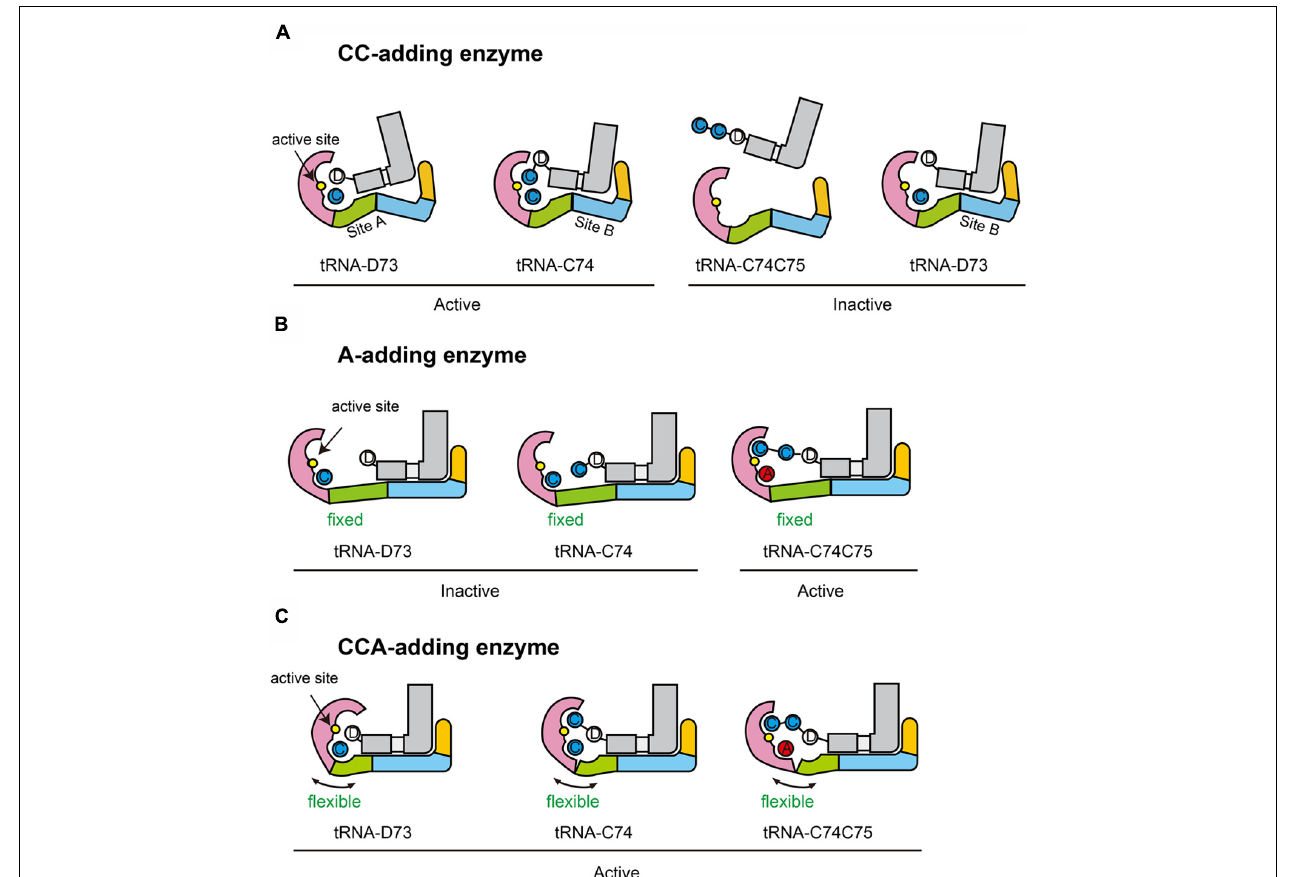
FIGURE 8 | Hypothetical mechanisms of nucleotide addition by class-II enzymes. (A) CC-addition by CC-adding enzyme possessing two tRNA binding sites (sites A and B). Sites A and B are used for C 74 - and C 75 -addition, respectively. When a tRNA ending with the discriminator nucleoside (D 73 ) is on site B, the 3 (cid:2) -terminal D 73 cannot reach the active site for catalysis (inactive state). A tRNA ending with C 74 C 75 cannot bind either site A or B. (B) A-addition by A-adding enzyme, possessing a single tRNA binding site. The neck domain is not flexible. The tRNA binds the enzyme, using the single site. On this site, the 3 (cid:2) -terminal nucleoside of a tRNA ending in either a discriminator nucleoside (tRNA-D 73 ) or C 74 (tRNA-C 74 ) cannot